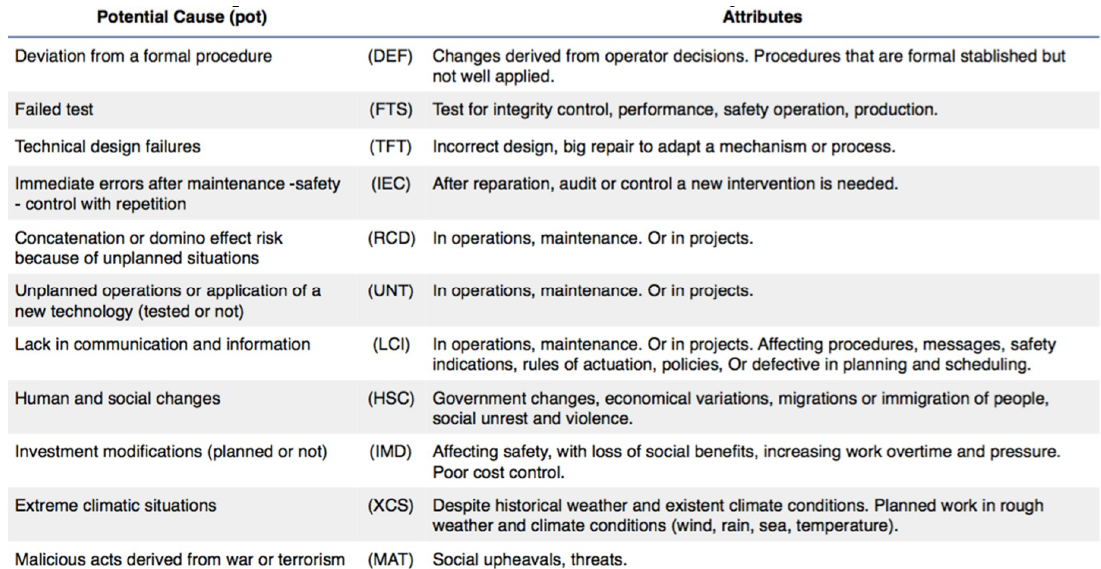
12 of 34 . Figure 7. Analysis modes of the hidden Markov chain. ( a ) Defining transition probabilities for the mitigative barriers (highlighted green) and emission probabilities for the observed end sates in function of the mitigative barriers (highlighted brown); ( b ) defining transition probabilities for the end states (highlighted green) and emission probabilities for the observed mitigative barriers states (highlighted brown).